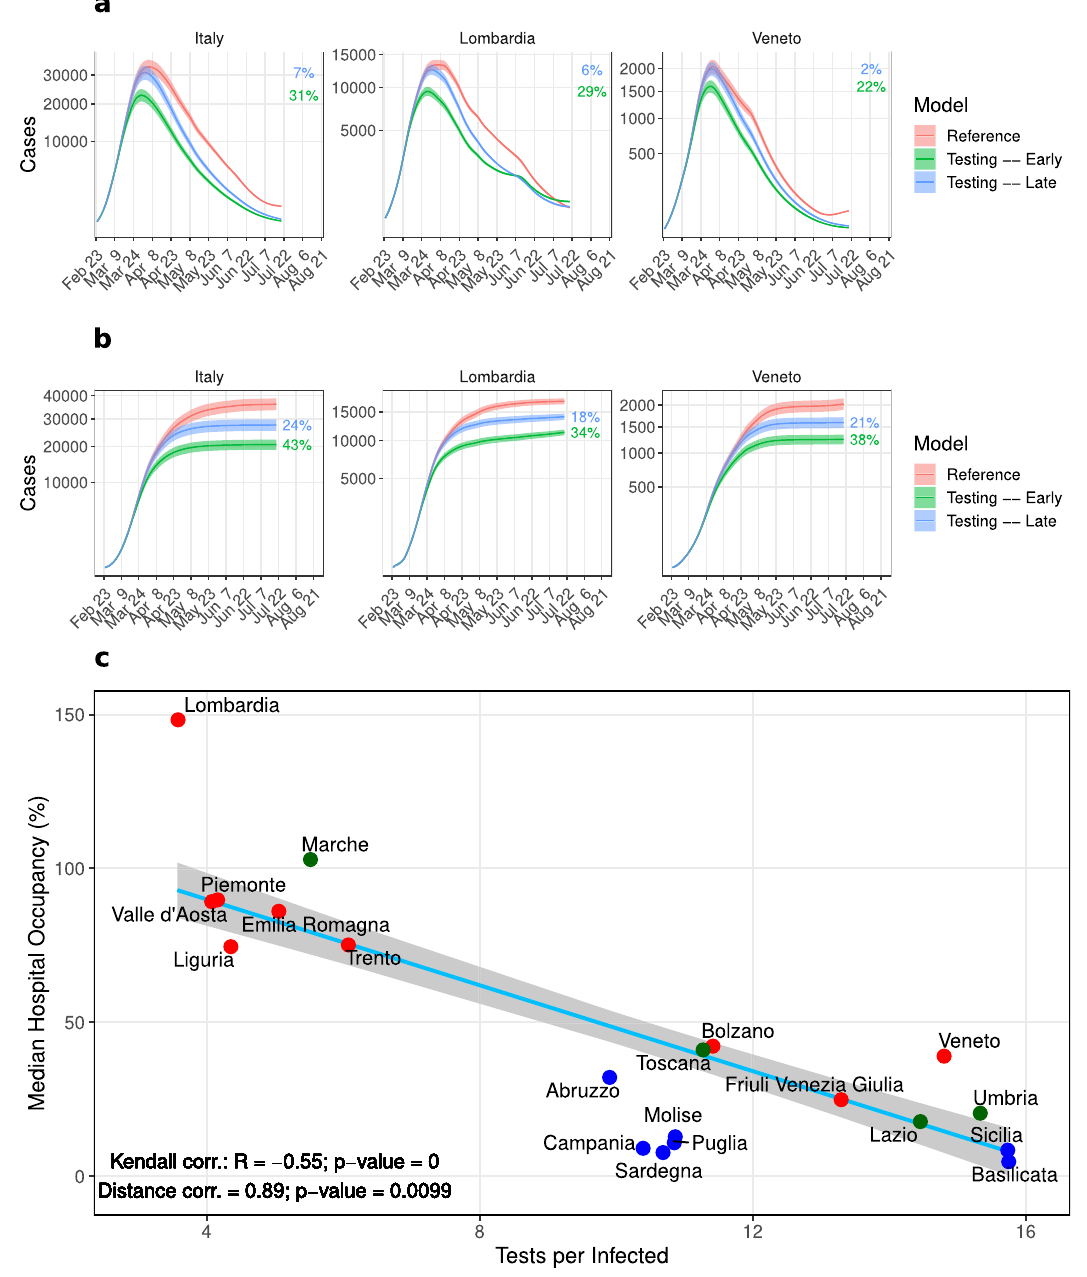
Fig. 5 Impact of testing and isolation on hospitalization and death. a , b Simulation results of the Testing Model in two scenarios: undetected cases are decreased from (cid:1) μ ¼ 90 % to 60% starting one week before the lockdown (green) and one week post lockdown (blue). a Sum of hospitalized including ICU patients. b Total deaths. The percentages provided in panels A and B quantify the reduction in peak with respect to the fi tted Reference Model (red line). Statistics were performed by fi tting the data with 100 perturbed parameter sets (see Methods). Continuous line and shaded region represent the mean and standard deviation, respectively. c Kendall and Distance correlations have been performed between the number of tests per infected and the median hospital occupancy, de fi ned as the median of daily hospitalized over the pre-pandemic hospital plus Intensive Care Units (ICU) beds. Light blue line: linear regression fi t over 20 regions; gray shaded area: standard error; red dots: northern regions; blue dots: southern regions; green dots: central regions. R : correlation coef fi cient; p : signi fi